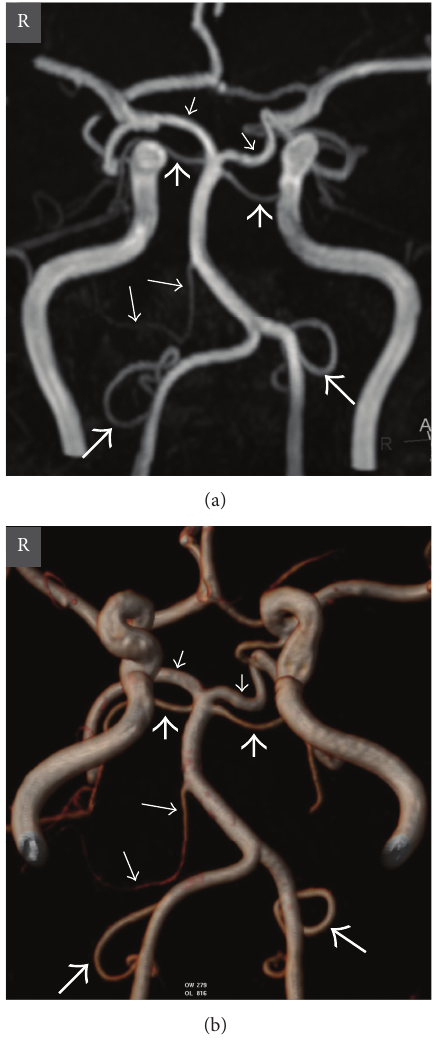
Figure 4: Oblique coronal view MIP (a) and VR (b) TOF MR angiography images show absence of the left AICA, well-developed left PICA, and moderately developed right PICA in a 48-year-old woman. Thick long arrows = right and left PICAs, thin long arrow = right AICA, thick short arrows = right and left SCAs, thin short arrows = right and left PCAs, and R = right.